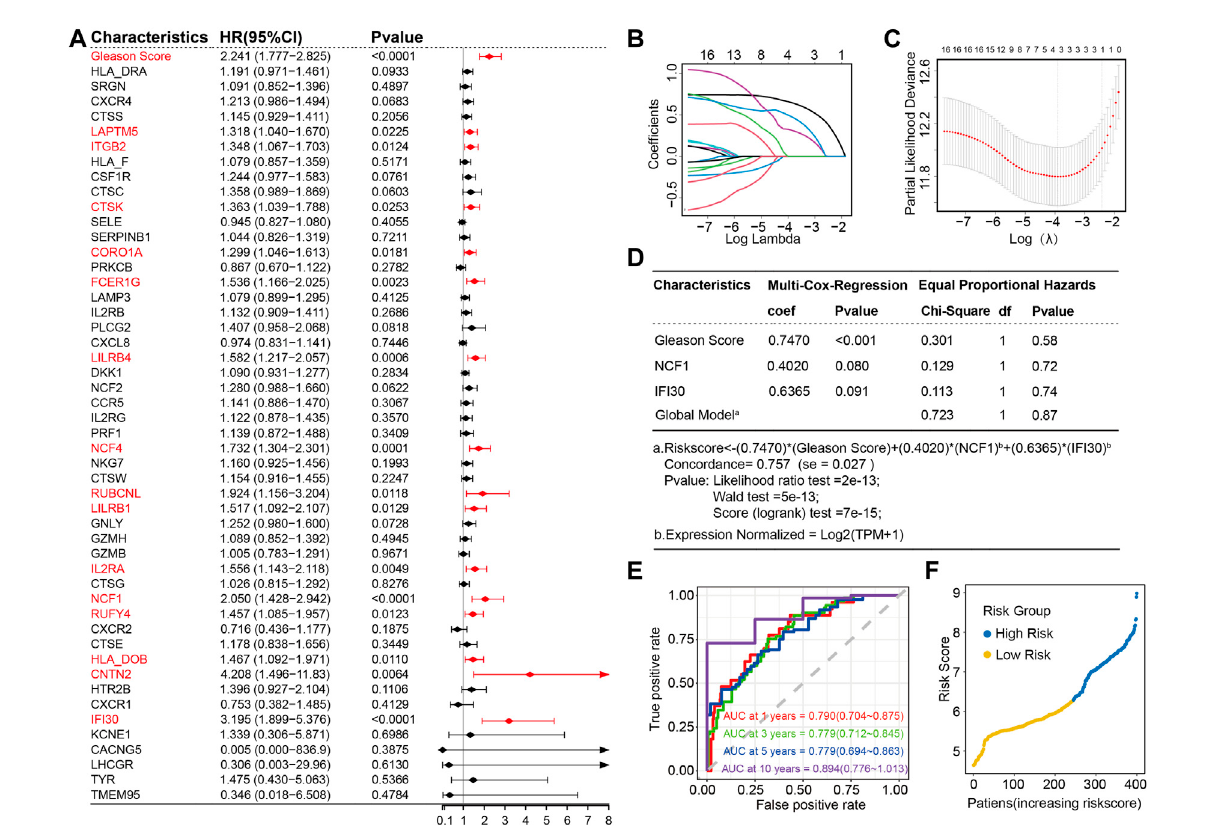
FIGURE 3 Construction of two LIRG prognostic signatures based on Gleason score as a risk model in the training set (A) Forest plot of the Gleason score and 49candidate LIRGsex-pression byaunivariateCoxregression analysis; (B) Lasso regressionofthe49candidate LIRGs; (C) Cross-validationintheLASSO regression; (D) Multivariable Cox regression analysis of the selected factors; (E) Time-dependent ROC curves for the prognostic signatures of 1, 3, 5 and 10-year PFI of PRAD in the training set; (F) Distribution of the risk